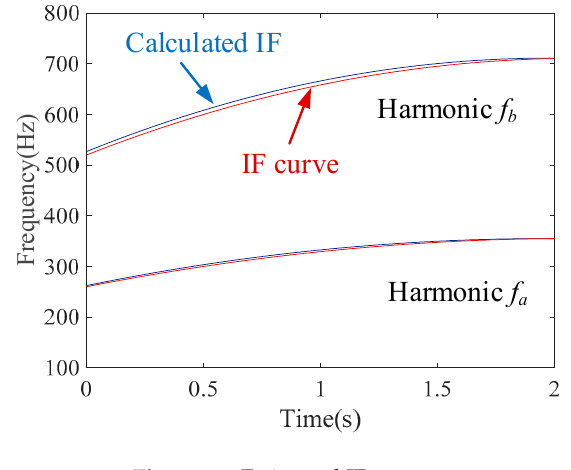
Figure 13. Estimated IF curves.